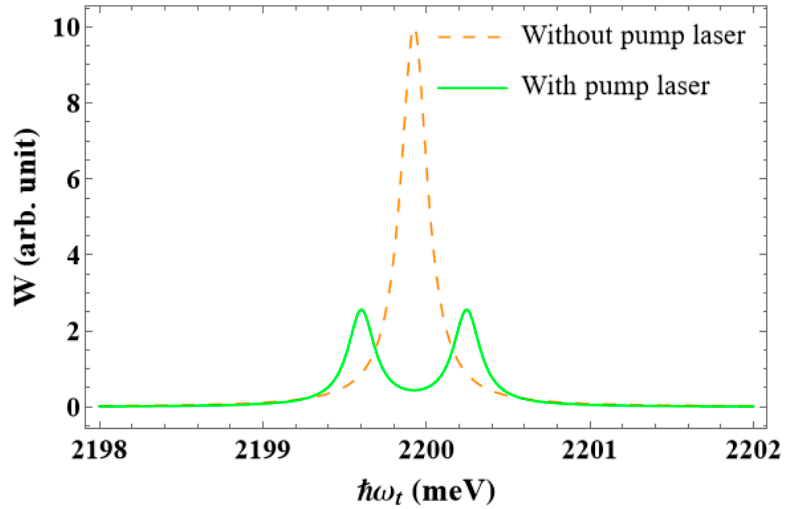
Figure 5. The interband absorption spectra as a function of the apical angle, with dot radius R = 50 Å, in the absence of a pump laser.